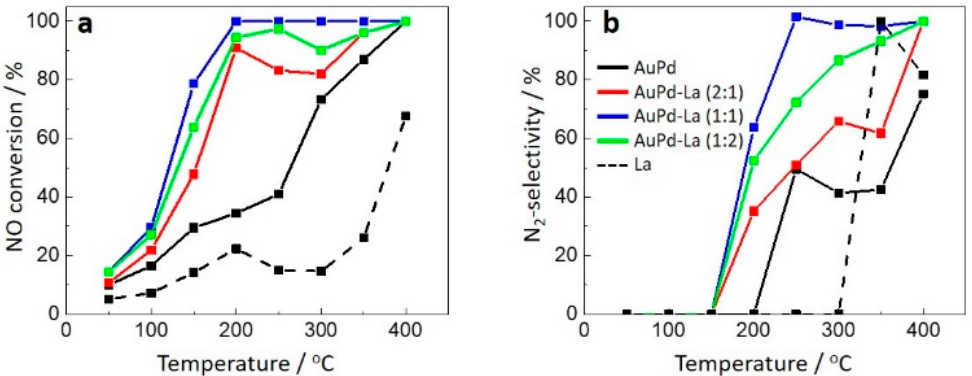
Figure 4. ( a ) NO conversion and ( b ) N 2 -selectivity during catalytic reduction of NO with CO; Gas mixture: 2000 ppm NO, 2000 ppm CO, He balance; Total flow rate: 150 mL/min; GHSV: 12,000 h − 1 ; Reaction temperature: 50–400 °C.